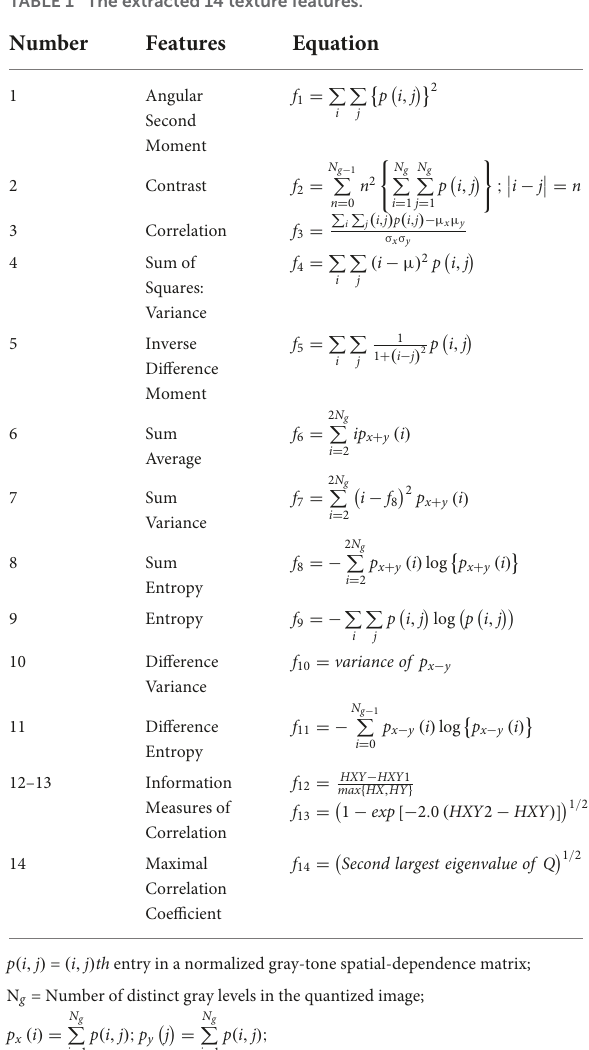
TABLE 1 The extracted 14 texture